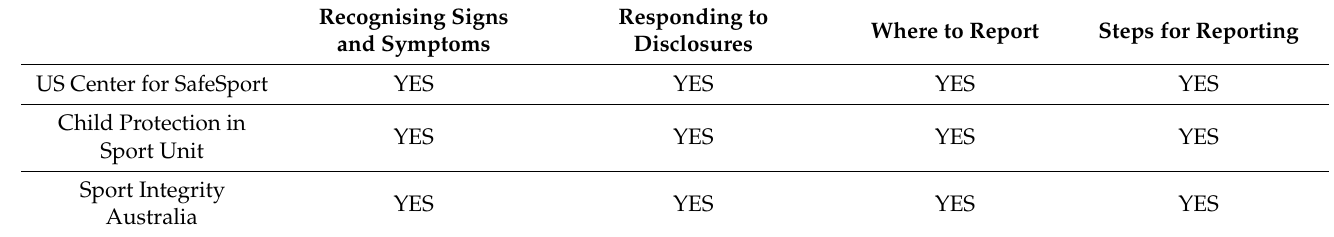
Table A2. Reporting Processes Introduced in Basic Safe Sport Courses by Each Organisation.